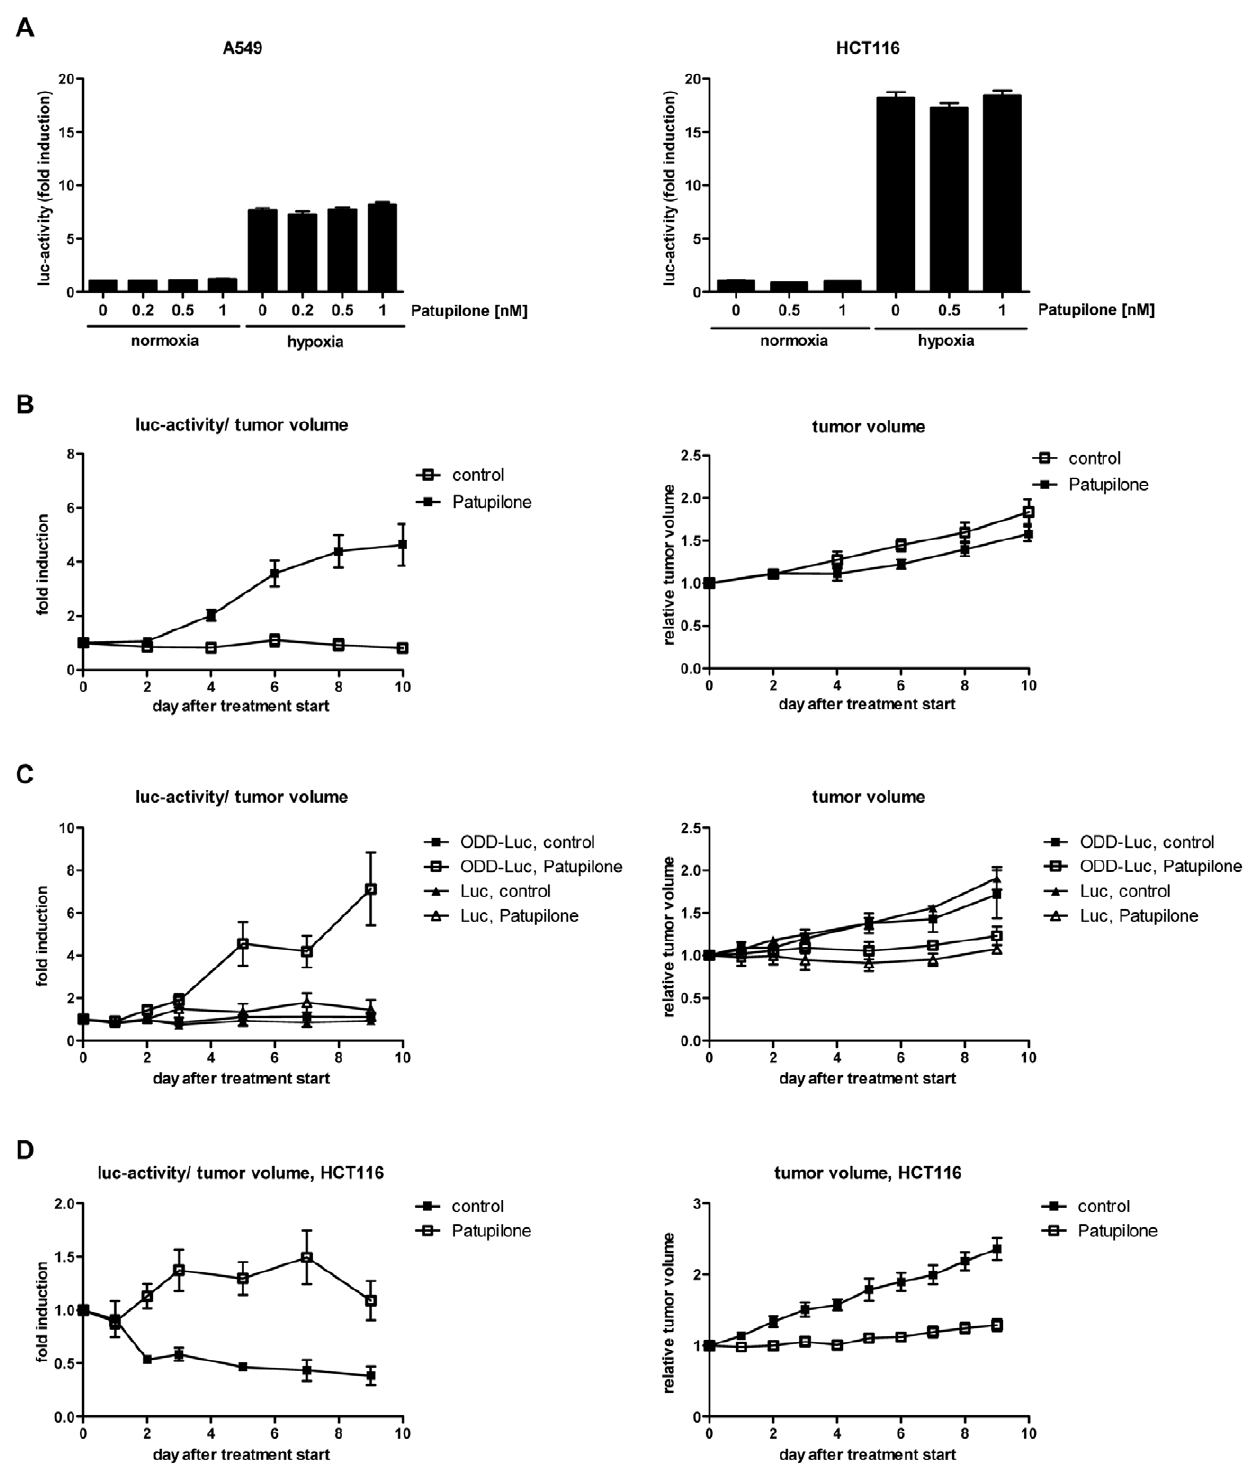
Figure 4. Patupilone-dependent increase in tumor hypoxia invivo . (A) Stably-transfected A549 ODD-Luc and HCT116 ODD-Luc cells were treated with increasing concentrations of patupilone for 24 hours before incubation under normoxia and hypoxia (0.2% O 2 ). Luciferase activity was determined after 8 hours of hypoxia. Error bars represent mean 6 SE. (B) Luciferase activity (left side) and tumor growth (right side) of A549 ODD-Luc- derived tumor xenografts in mice treated with patupilone (2 mg/kg). (n control =7; n patupilone =19) (C) Luciferase activity and tumor growth of A549 ODD-Luc and A549 Luc-only-derived xenografts in mice treated with patupilone (2 mg/kg). (n ODD-Luc =5; n Luc =3) (D) Luciferase activity and tumor growth of HCT116 ODD-Luc-derived xenografts in mice treated with patupilone (2 mg/kg). (n control =7; n patupilone =12) Error bars represent mean 6 SE of fold induction luciferase activity/tumor volume or relative tumor volume per group.